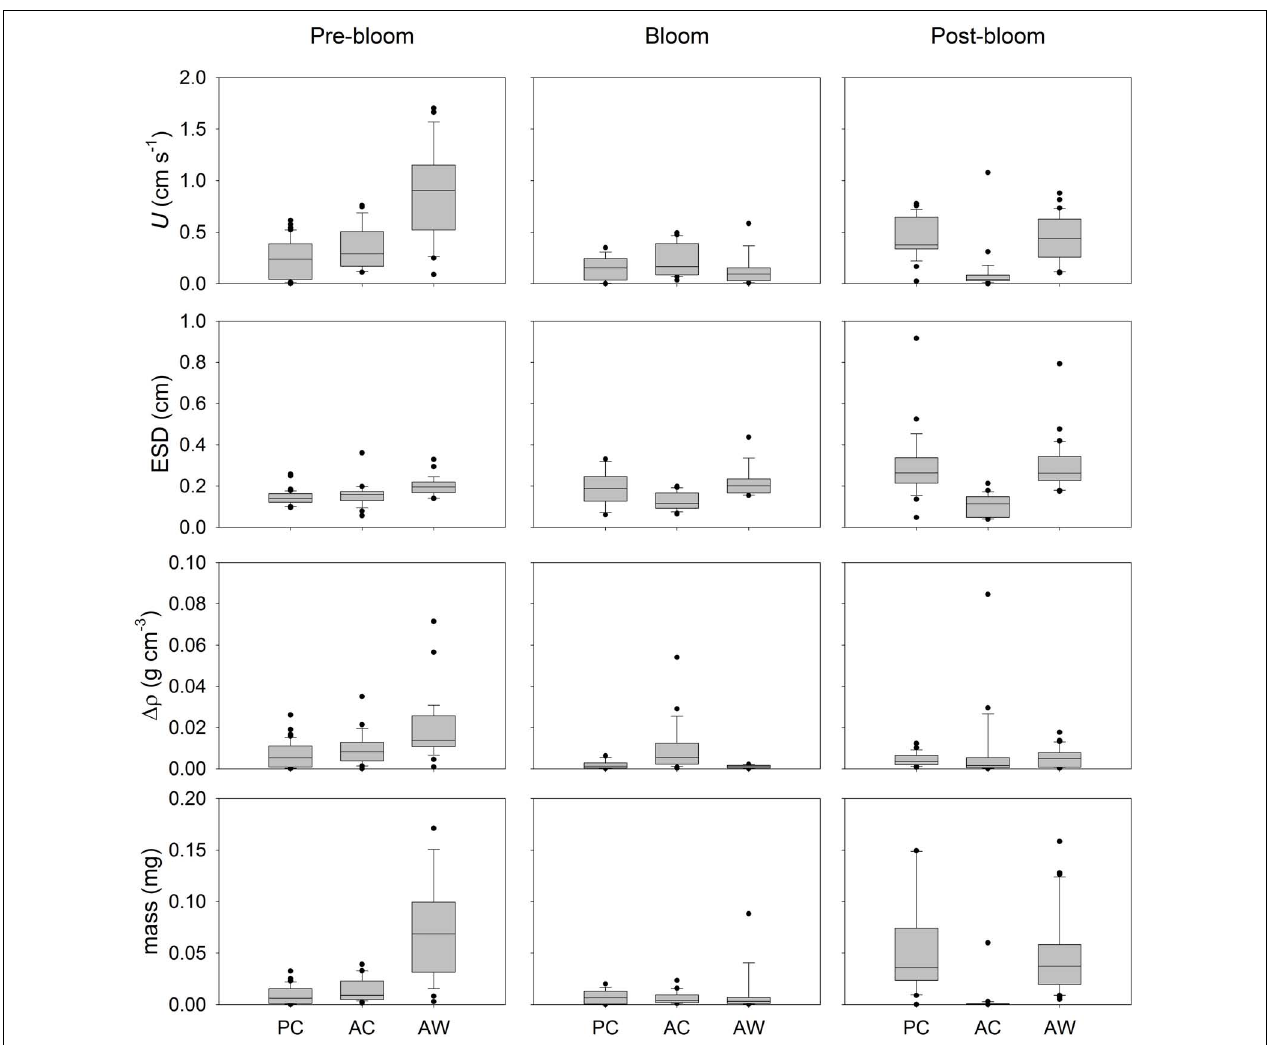
FIGURE 5 | Sinking velocity and physical properties of aggregates formed in RTEs conducted at different bloom periods. The box plots include all the individually-measured aggregates ( > 0.4 mm) from the different roller tanks (RT) in each treatment. For Pre-Bloom, PC included 29 aggregates from two RT, AC included 29 aggregates from three RT, and AW included 29 aggregates from two RT. For Bloom Peak, PC included 25 aggregates from two RT, AC included 26 aggregates from two RT, and AW included 15 aggregates from one RT. For Post-Bloom, PC included 27 aggregates from two RT, AC included 26 aggregates from two RT, and AW included 30 aggregates from two RT. The boundaries of the box indicate the 25 th and the 75 th percentile, the black line within the box is the median. Error bars indicate the 90 th and 10 th percentiles, and black dots are the outlying